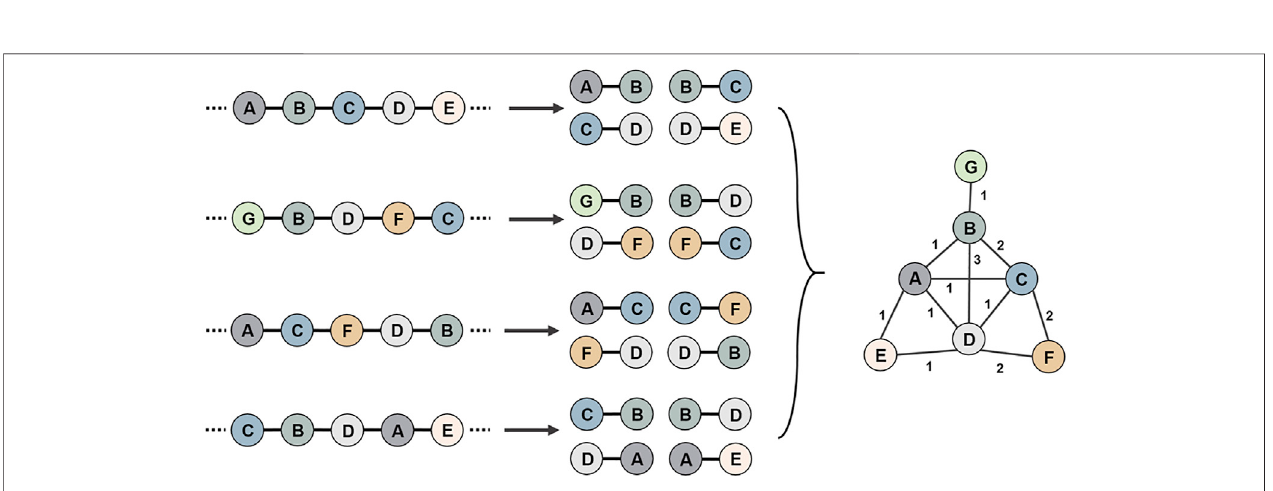
FIGURE2| Schematicdiagramoftheuseofmultiplegenomestoconstructagenesyntenynetwork.First,allgenomicgenesarecomparedforsequencesimilarity, and genesthatsharehighreciprocalsimilarity andcoverratiosareassignedthesamenode id.Then,positionalrelationshippairsbetweentwogenesfromeach genome were constructed. Finally, all gene position relationship pairs are connected into a gene synteny